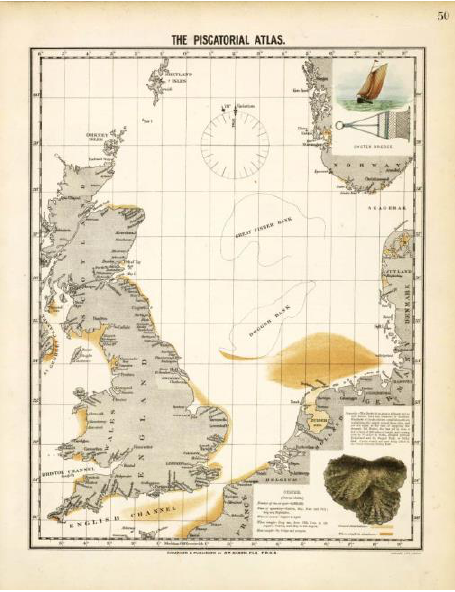
Figure 2. Piscatorial Atlas Map on the distribution of the European oyster in the North Sea (Olsen 1883).